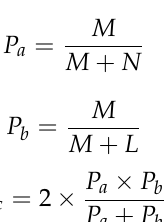
Table 2. Comparison of detection performance based on image processing algorithms.